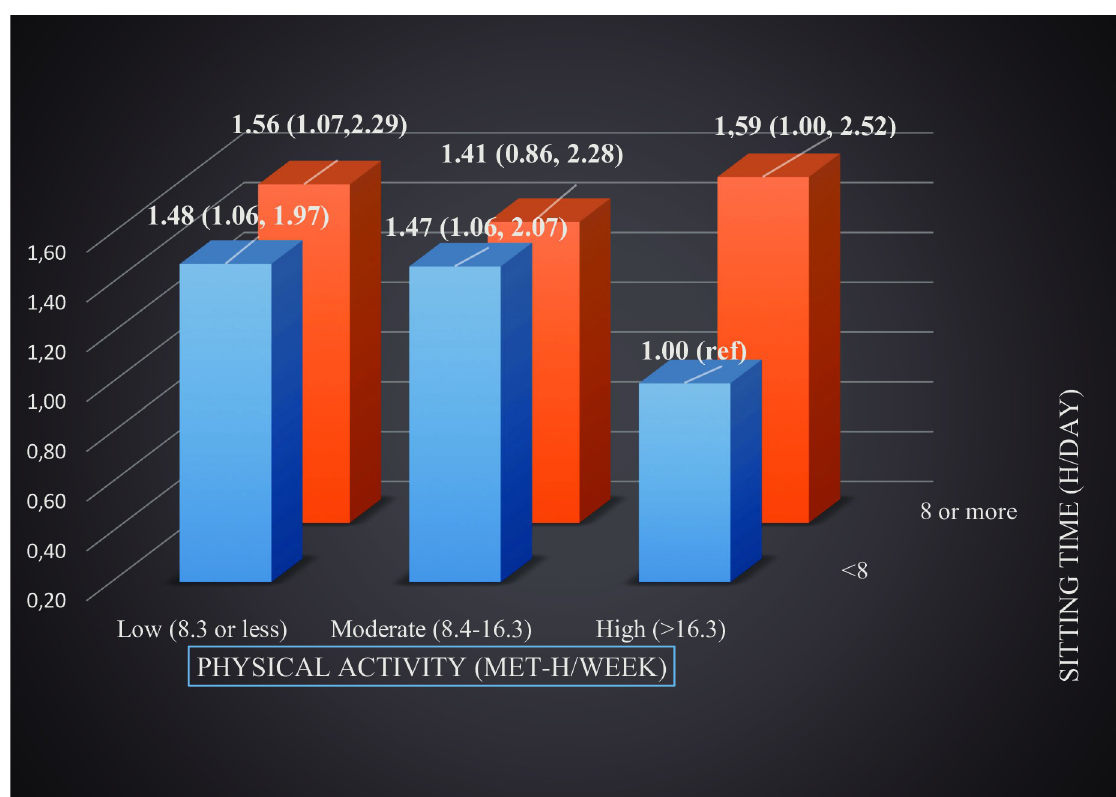
Fig 3. Joint association of sitting time and physical activity with colorectal cancer, adjusted HRs in men.